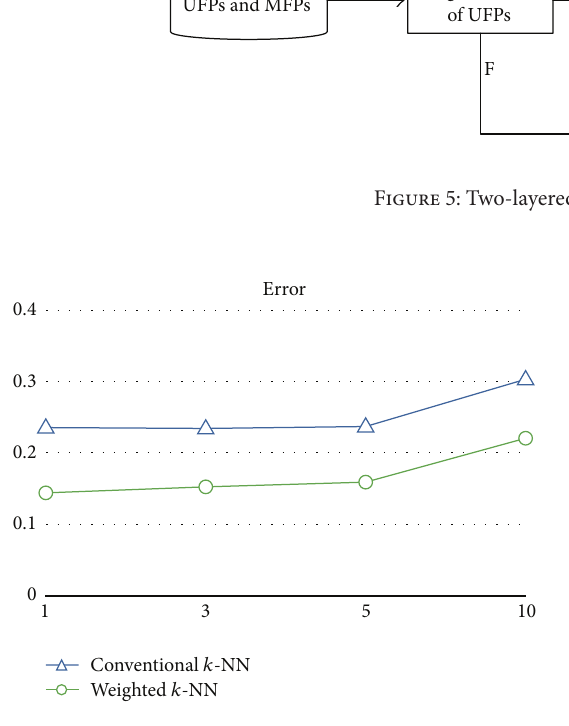
Figure 7: F-measure of the conventional 𝑘 -NN classifier and the weighted 𝑘 -NN classifier on different 𝑘 .